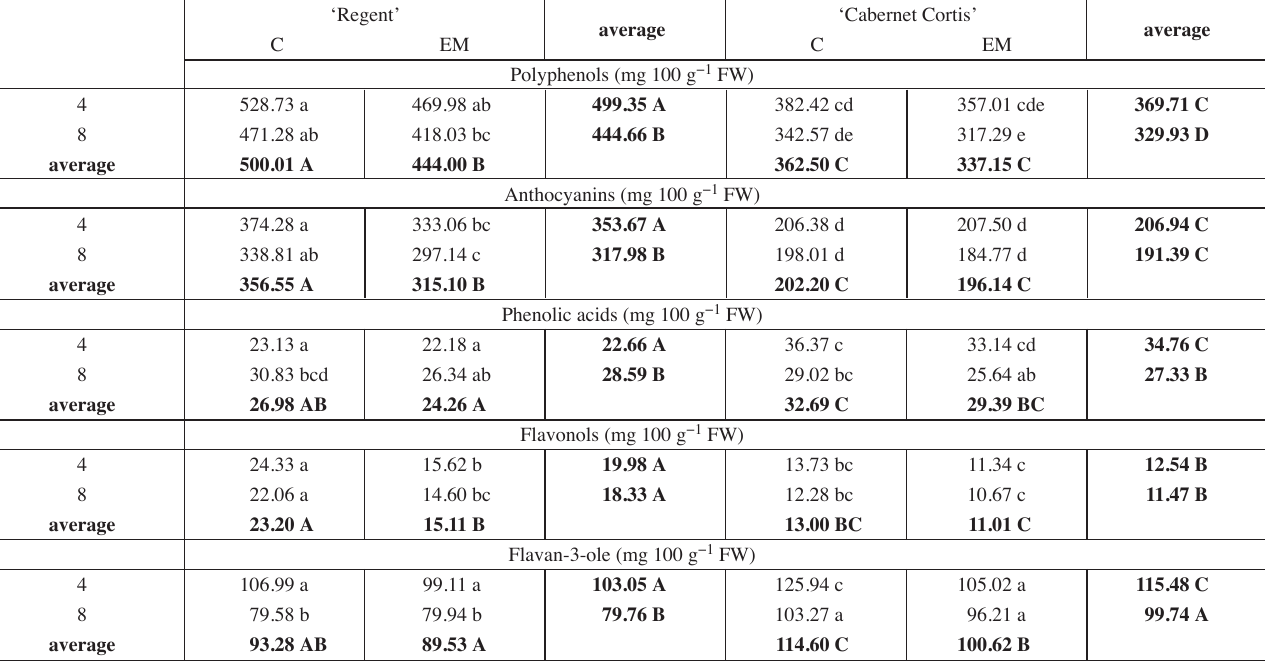
‘Regent’ ‘Cabernet Cortis’